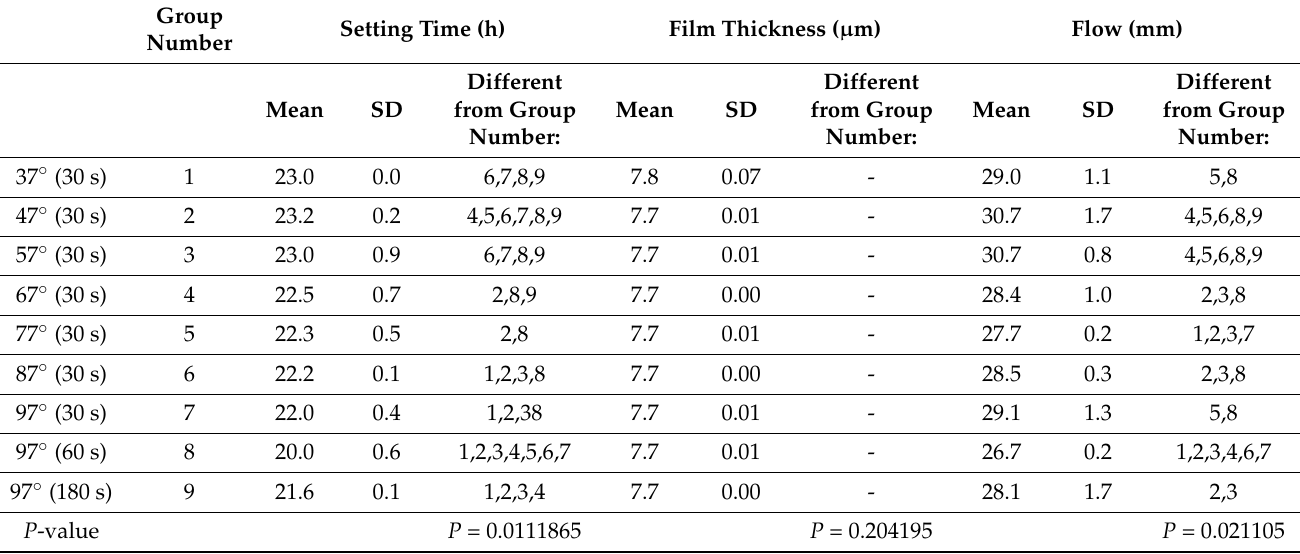
Table 4. Physical properties in accordance with ISO 6876:2012 of Total Fill BC Sealer HiFlow (means and standard deviations (SD)) after thermal treatment. Statistical analysis of setting time, film thickness and flow for Total Fill BC Sealer HiFlow was performed by Kruskal-Wallis-Test ( P =